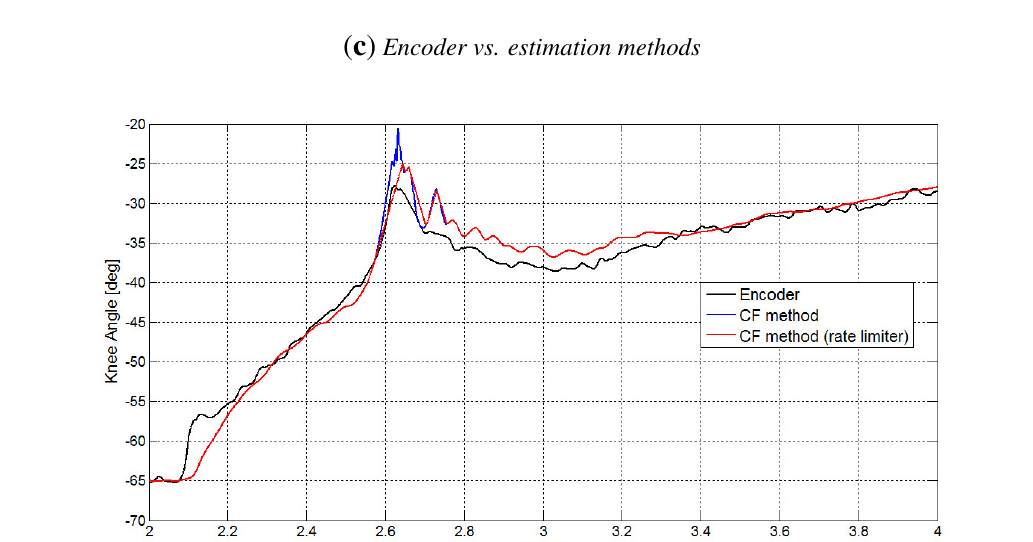
( d ) Zoomed section of figure